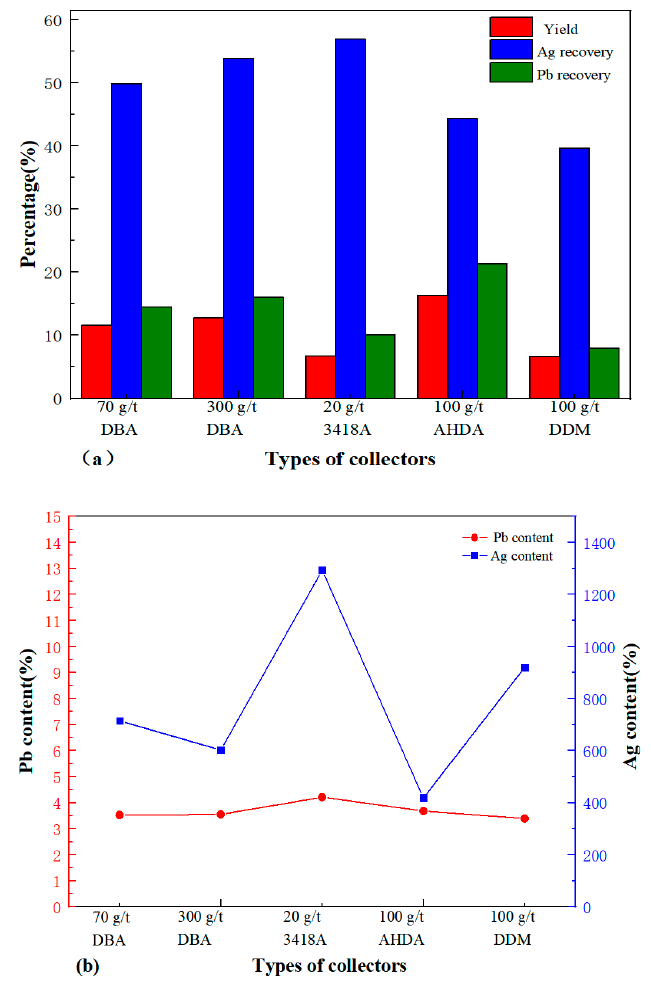
Figure 5. ( a ) Yield and recovery of products under different collector conditions; ( b ) content of products under different collector